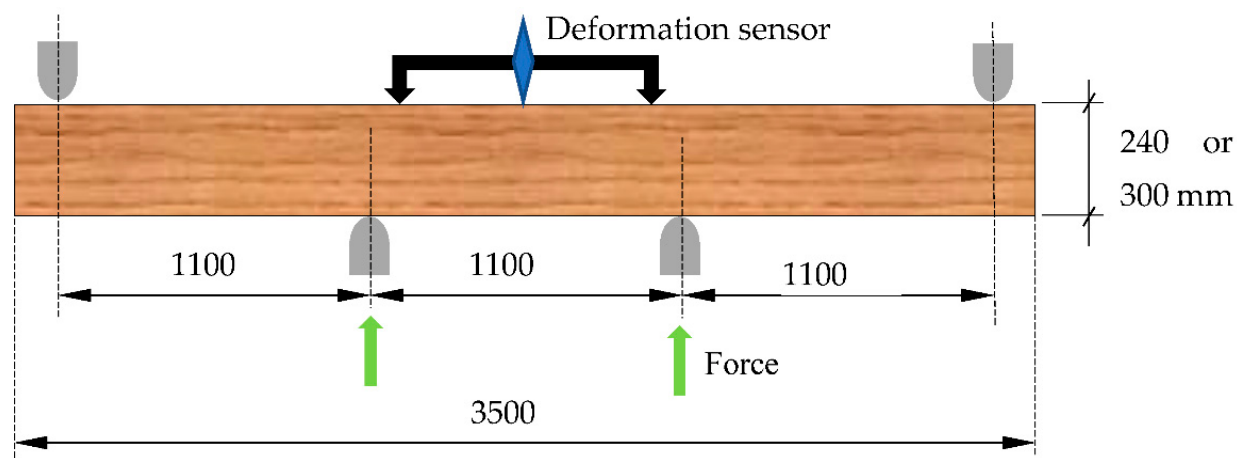
Figure 5. Schematic of the tested beam.